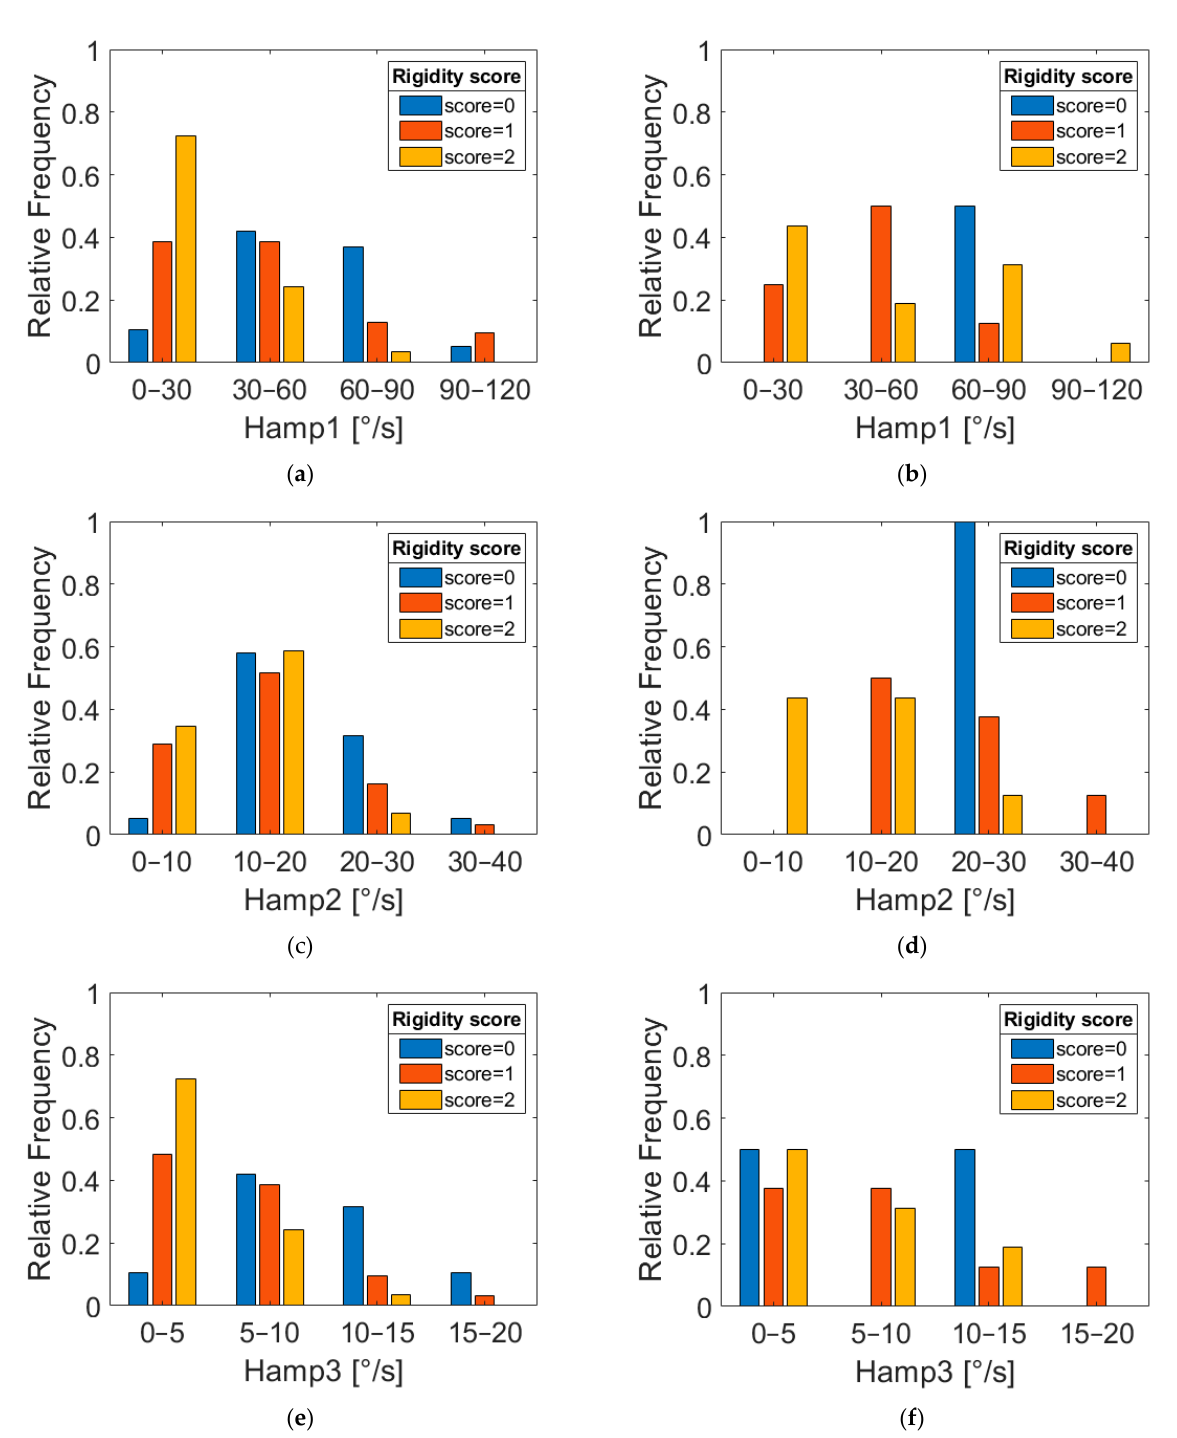
Figure 6. Relative frequency distributions of features Hamp1, Hamp2 and Hamp3 for PD-DN ( a , c , e ) and PD-OFF ( b , d , f ) subjects grouped according to three different UPDRS rigidity scores (item 3.3).